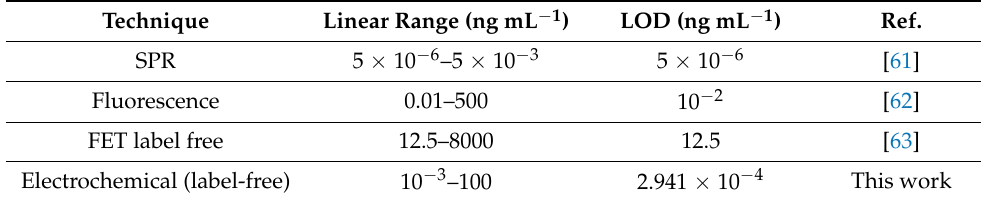
Table 2. Comparison with other aptamer-sensing systems for CRP